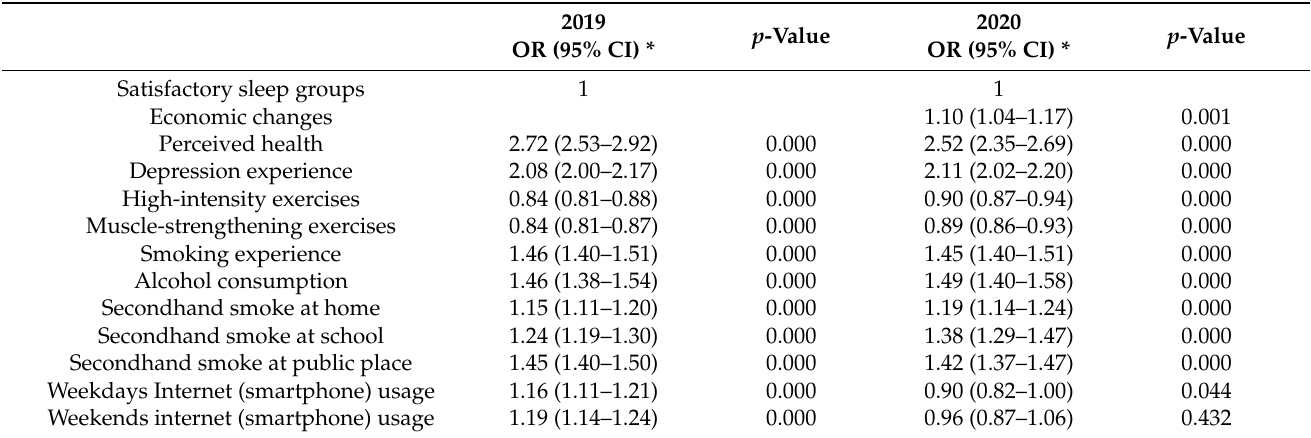
Table 4. Relationship between sleep satisfaction and health